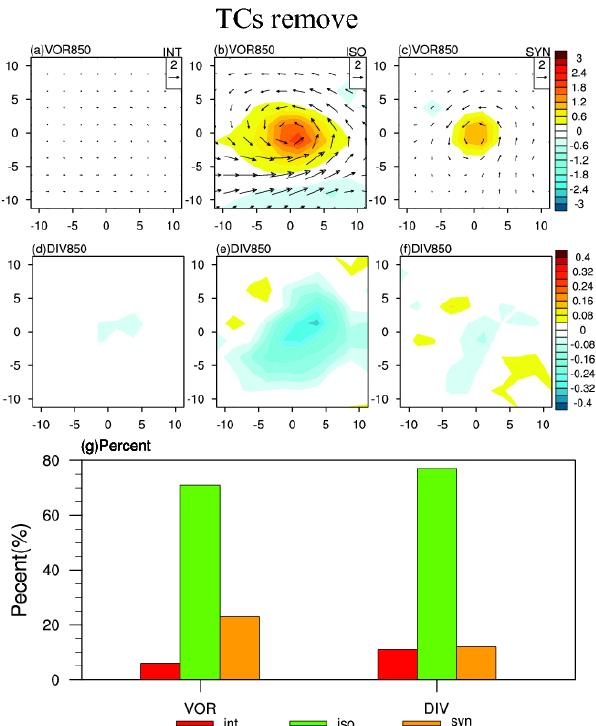
Figure 7. Composite of ( a – c ) 850 hPa wind (vector, m/s, scale at the top right) and relative vorticity (shading, 10 − 5 s − 1 ), ( d–f ) 850 hPa divergence (shading, 10 − 5 s − 1 ) centered over the locations of TC formation on (left) interannual, (middle) intraseasonal, and (right) synoptic time scales during AMJJASOND from 1979 to 2020 with the TC signals removed. The zero indicates the grid point nearest to the TC formation locations. The x-axis (y-axis) represents the distance ( ◦ ) from the TC center with positive distance to the east (north) and negative distance to the west (south). The percent (%) contributions ( g ) from anomalies of 850 hPa relative vorticity (VOR) and 850 hPa divergence (DIV) on interannual (red bar), intraseasonal (green bar), and synoptic (orange bar) time scales with the TC signals